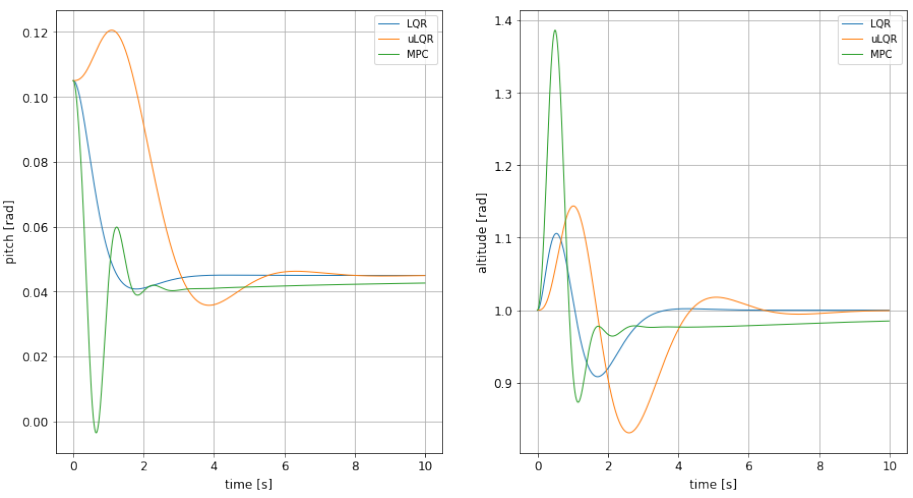
Figure 15. Comparison between the altitude and pitch dynamic for LQR, updating LQR and non- linear